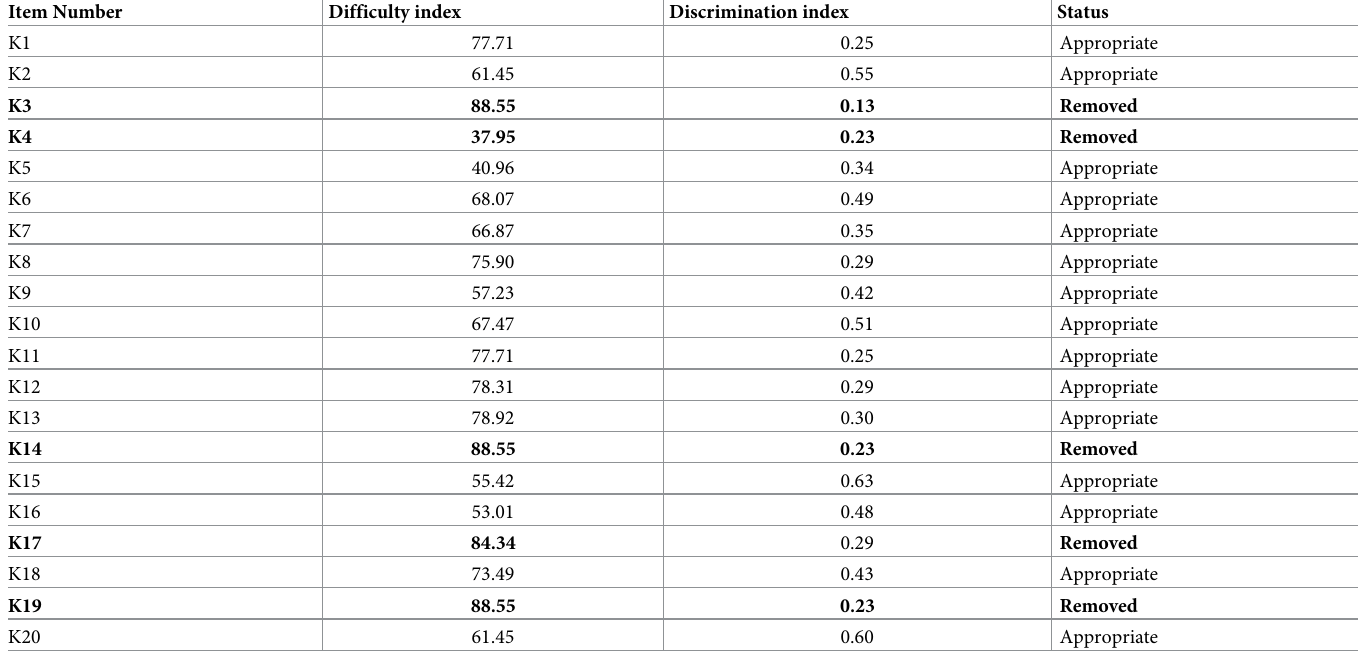
Table 2. Validity and reliability analysis for knowledge construct.